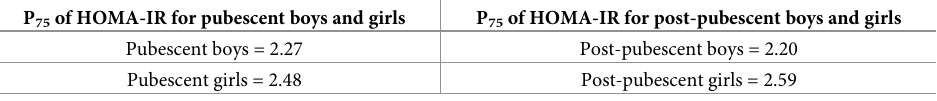
Table 1. 75 th percentile of Homeostatic Model Assessment for insulin resistance according to sexual maturation stage. ERICA study, 2013–2014. P 75 of HOMA-IR for pubescent boys and